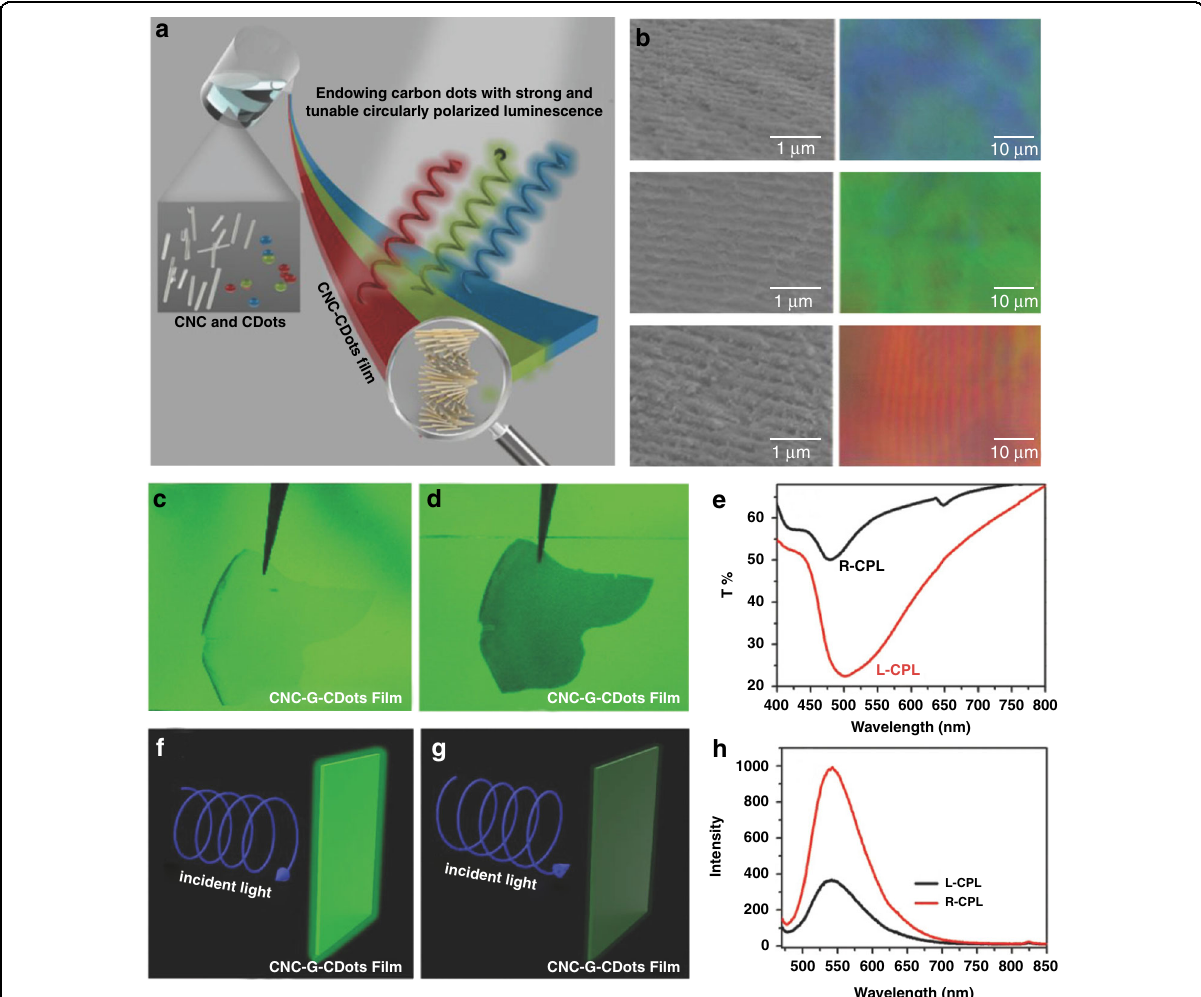
Fig. 8 Chiral luminescent nanomaterials based on liquid-crystalline CNCs. a Schematic evaporation-induced co-assembly of carbon dots and CNC. b SEM images and polarized optical microscope images of chiral nanomaterials. c , d Transparent fi lm and dark fi lm upon exposure to right- and left-handed circularly polarized light, respectively. e Transmission spectra with left-handed and right-handed circularly polarized light. f – h Schematic representation of detecting circularly polarized light. Reproduced with permission from ref. 257 . Copyright 2018,